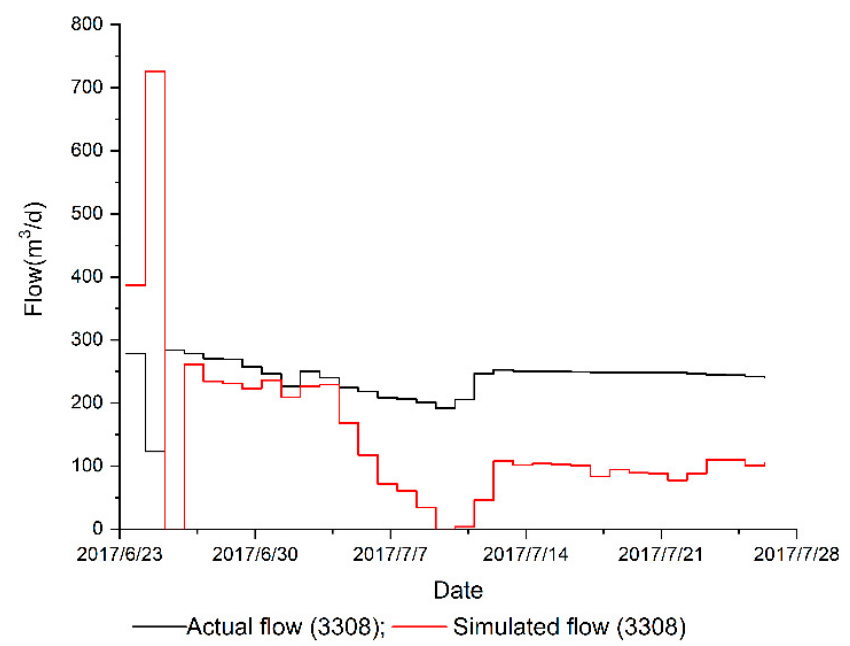
Figure 6. Flow regulation curve of 3308 injection well at the edge of mining area.